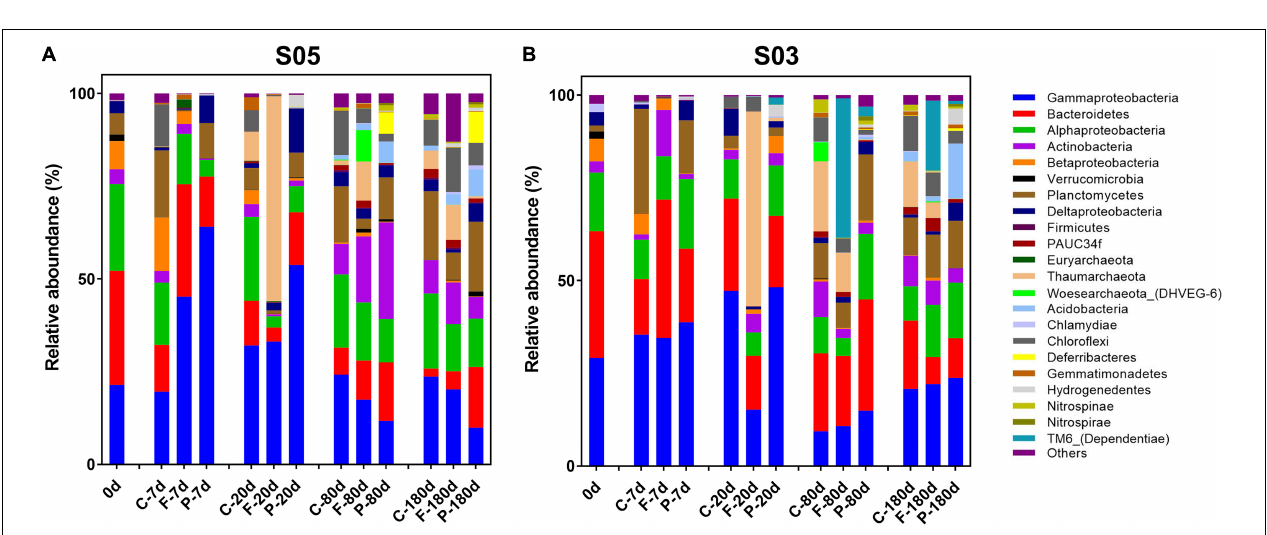
FIGURE 3 | Characterization of FDOM components identified throughout the incubation experiments. Excitation emission matrices are shown for the C1, C2, C3, and C4 components on the left panels (A–D) , respectively. Variation in abundance patterns for each component for the four components of station S05 are in the middle panels (E–H) . Finally, variation in abundance patterns for each component of station S03 is shown in the right panels (I–L) .